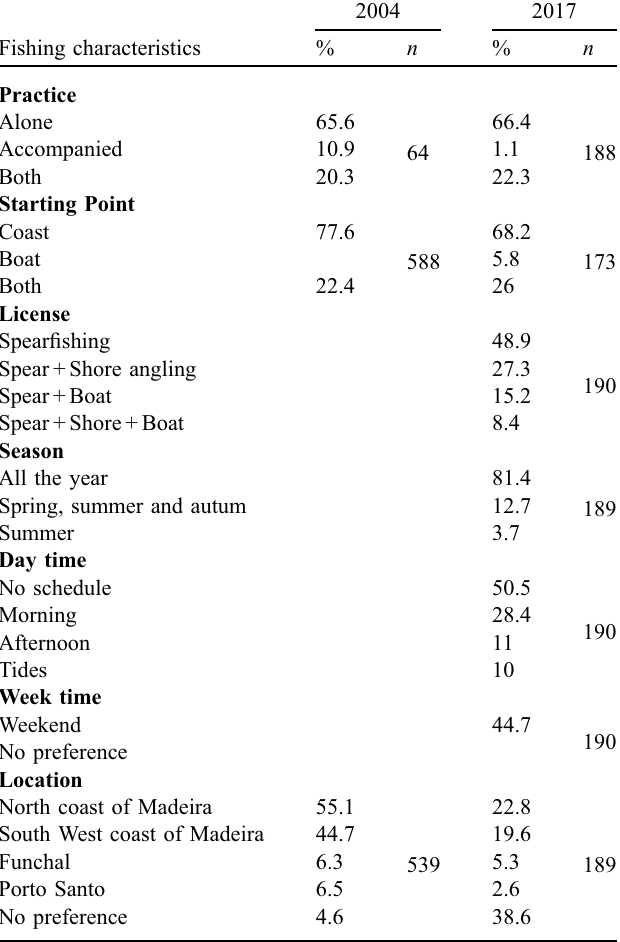
Table 2. Fishing